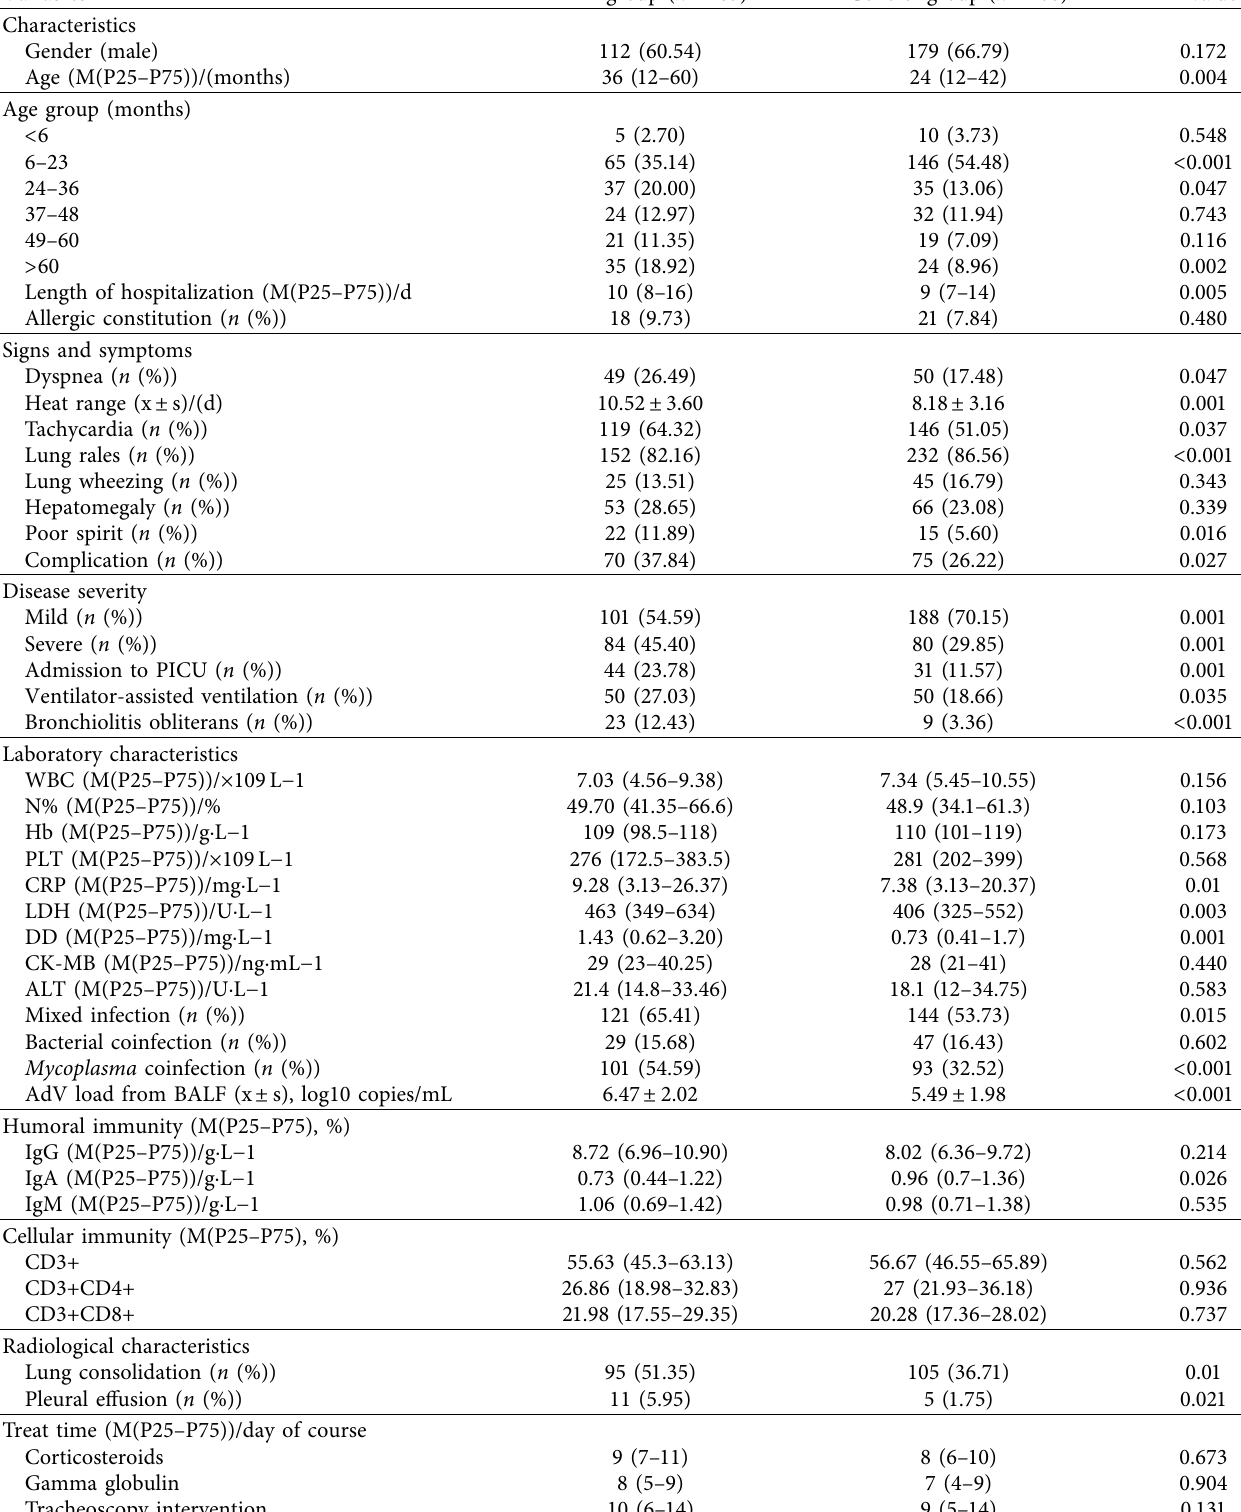
Table 1: Comparison of the clinical characteristics of patients with AdV pneumonia in the BMP and control group.